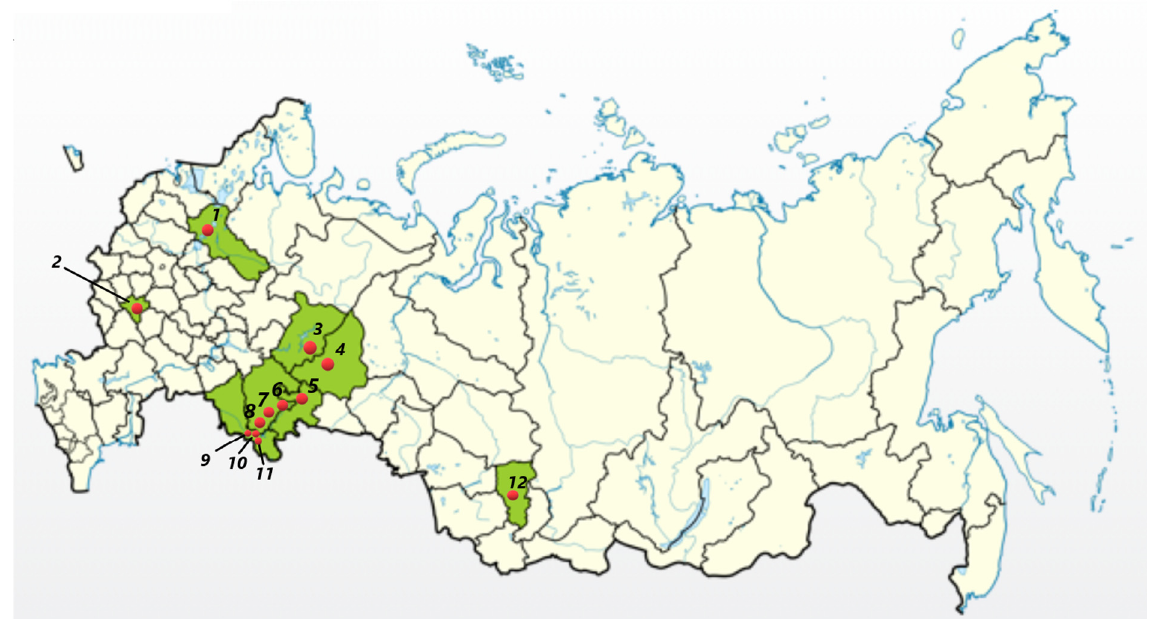
Figure 1. Metallurgical plants and tailing dumps of processing plants. 1: Cherepovets, 2: Novolipetsk, 3: Chusovoy, 4: Nizhny Tagil, 5: Chelyabinsk, 6: Uchalinsk, 7: Sibay, 8: Buribay, 9: Mednogorsk, 10: Guy, 11: Orsko Khalilovsky, 12: West Siberian.